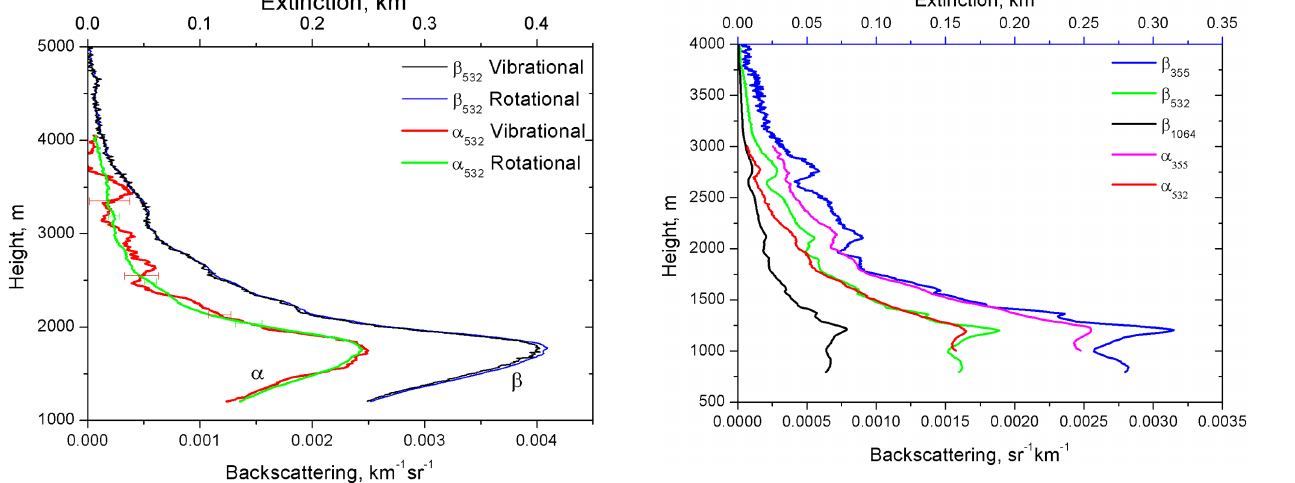
Figure 9. Particle backscattering and extinction coefficients at 532nm computed with the use of vibrational and rotational Raman scattering on 18 June 2014.